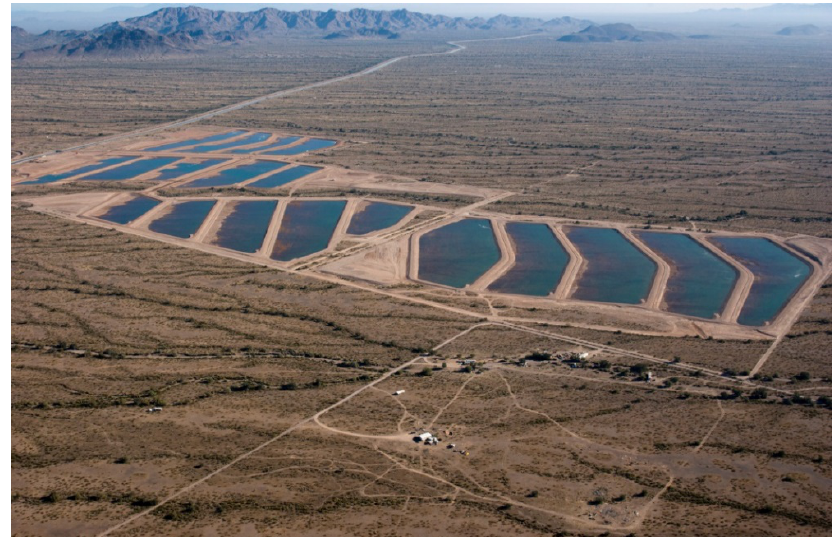
Figure 2. Tonopah Desert Recharge Project. Source: Central Arizona Project